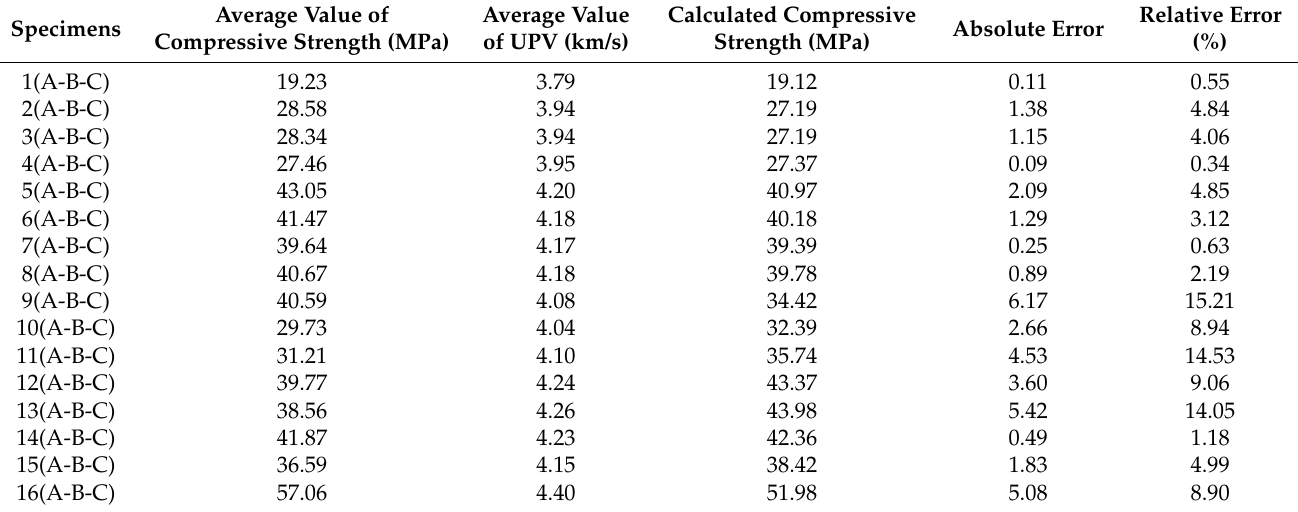
Table 4. Results obtained for the statistical analysis of lineal